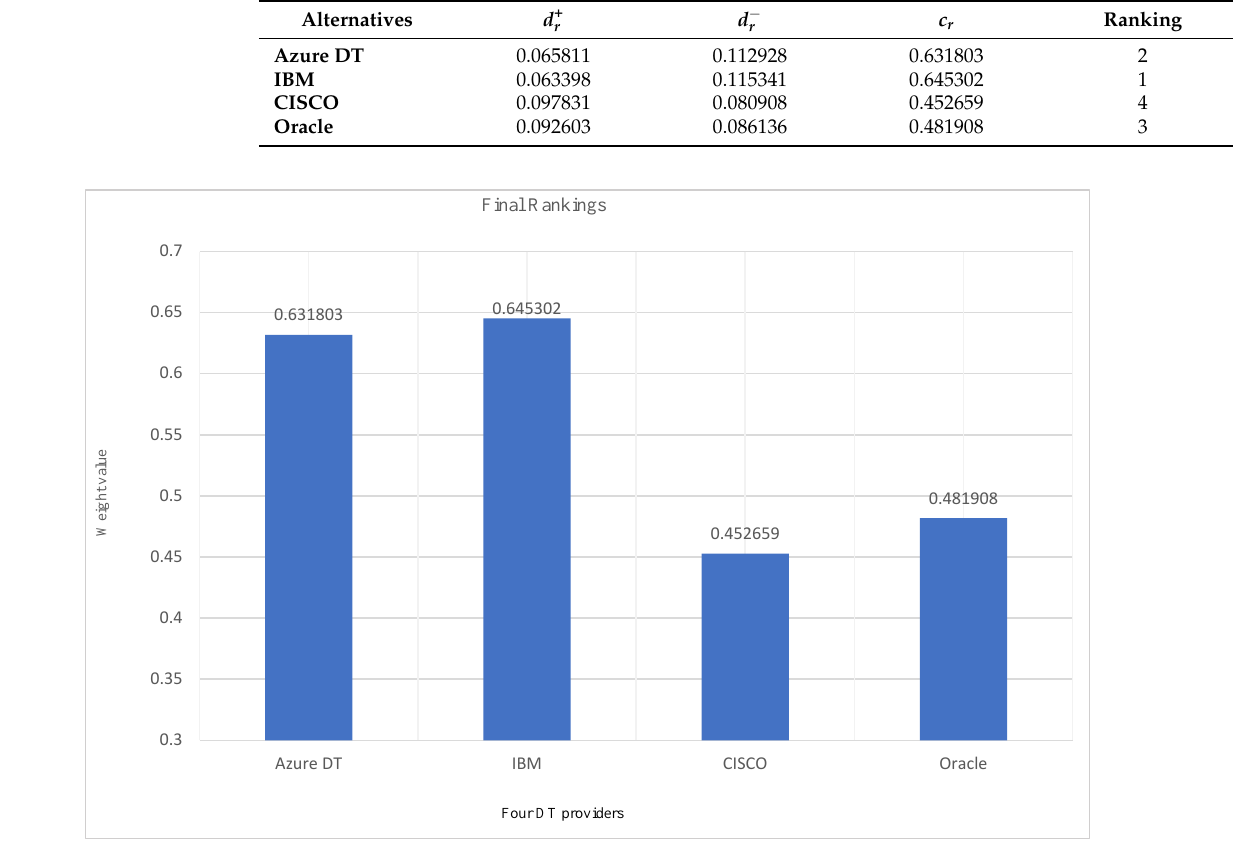
Figure 5. The final ranking for DT providers.